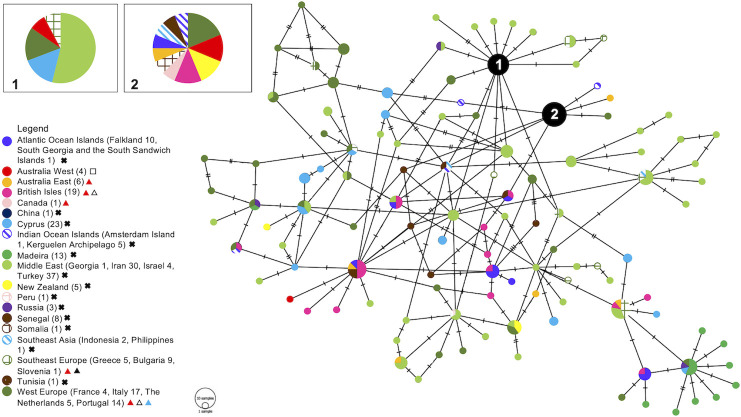
Minimum spanning haplotype network from Mus musculus domesticus D-loop data.The numbers in the legend are representative of the number of unique haplotypes included in the analysis. The size of each circle indicates the frequencies of the haplotype, and each colour represents the geographical origin of the sequences. The numbered nodes in the haplotype network correspond to the numbered inset boxes. A black cross in legend indicates that M. m. domesticus in that area has not been tested for anticoagulant rodenticide (AR) resistance [31]. A white square indicates that M. m. domesticus has been tested for Vkorc1 mutations related to AR resistance and was found to be negative (this study). A red triangle indicates that M. m. domesticus has been tested for resistance through a lethal feeding period test and was found to be resistant to ARs [5,8,20,25,26]. A white triangle indicates that M. m. domesticus has displayed Vkorc1 mutations related to AR resistance [20]. A black triangle indicates that a blood clotting response test has been performed and M. m. domesticus was found to be resistant to ARs [26]. A blue triangle indicates that an assay of the VKOR enzyme has been carried out and resistance to ARs was determined [5].